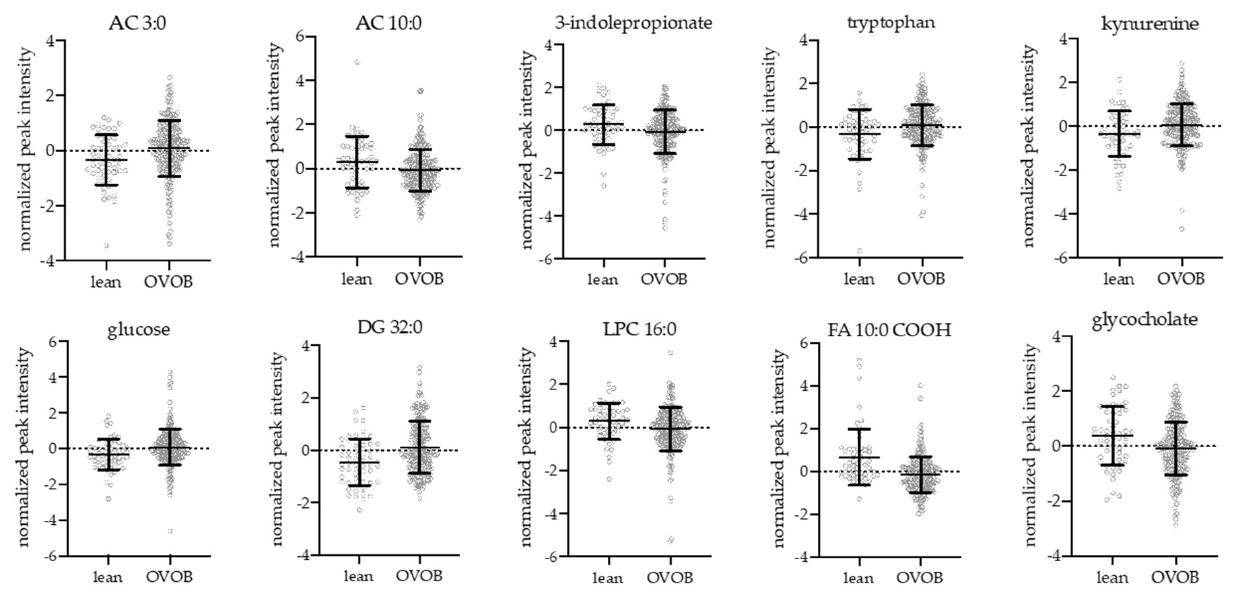
Figure 3. Differential metabolites between OVOB and lean participants during the Fasted OGTT Challenge. Linear regression analyses identified metabolites associated with the OVOB and lean groups at t0 (ß group ), adjusting for sex and age (FDR < 0.1, 66 metabolites). Selected differential metabolites represent metabolic pathways associated with obesity at t0. Normalized peak intensities and standard deviations are reported.